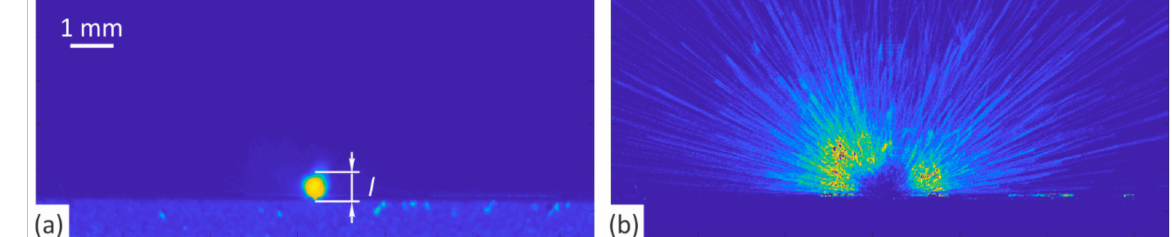
Figure 6. Results of the data processing that allowed ( a ) evaluation of the plasma cloud and ( b ) char- acterization of material ejections.